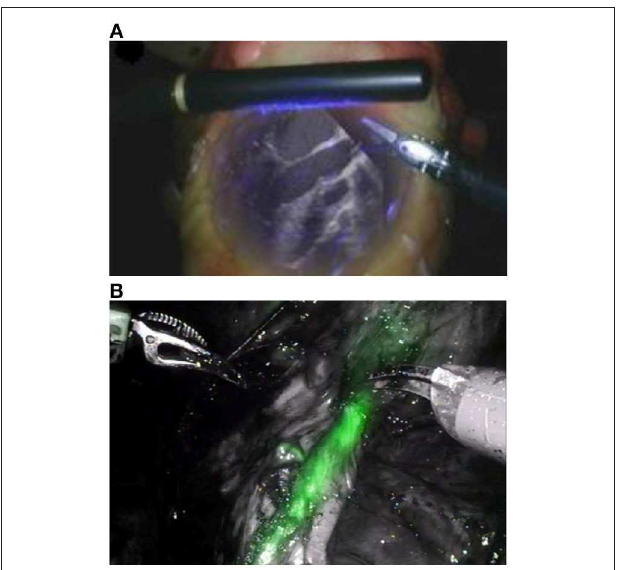
FIGURE 1 | (A) Augmented visible light and ultrasound image from Intuitive Surgical’s Da Vinci ultrasound probe ( Lee et al., 2010) and (B) visible light overlaid with NIRF from the Pinpoint Novadaq system (Kaplan-Marans et al., 2019). Both images are taken from real time video. Reproduced with permission from Elsevier.